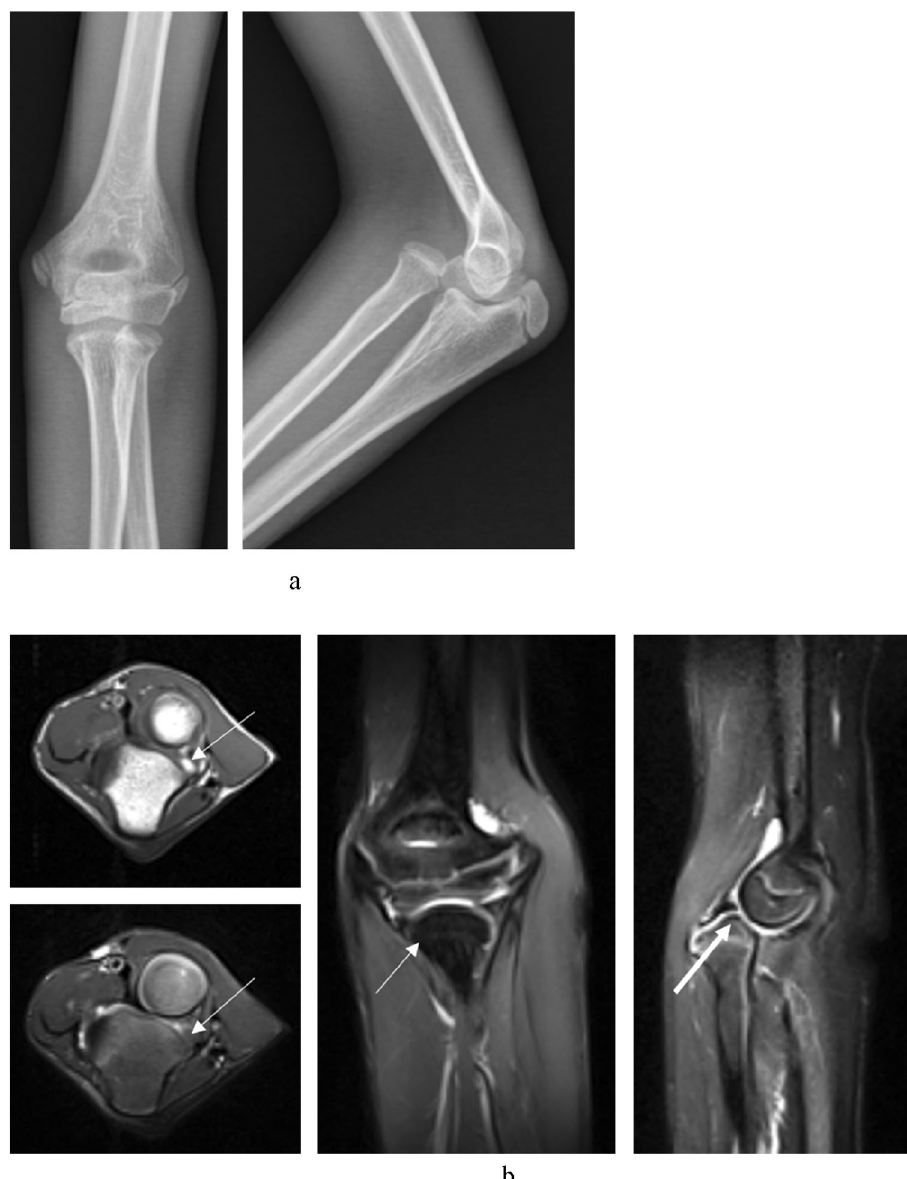
Figure 3. A 13 years old boy (case 12) with a missed Monteggia lesion after a 7 years interval. ( a ) Preoperative X-ray. The appearance of the radial head was domed. ( b ) Preoperative MRI. Axial T1- and T2-weighted images showed the proximal radioulnar joint was dislocated and the appearance of the radial notch (the arrow) was domed; coronal T2-weighted images showed the radial notch of the ulna was severe hyperplasia (the arrow); sagittal T2-weighted images showed the dislocation of the humeroradial joint and the domed radial head (the arrow) with dense fibrous scar tissue. ( c ) Open reduction and ulnar osteotomy with reconstruction of the annular ligament and a humeroradial pin was undertaken. ( d ) The radial head dislocated (Grade 5) due to the hyperplastic radial head incongruency with the capitellum and the elbow had osteoarthritic changes posteriorly at 3 years after